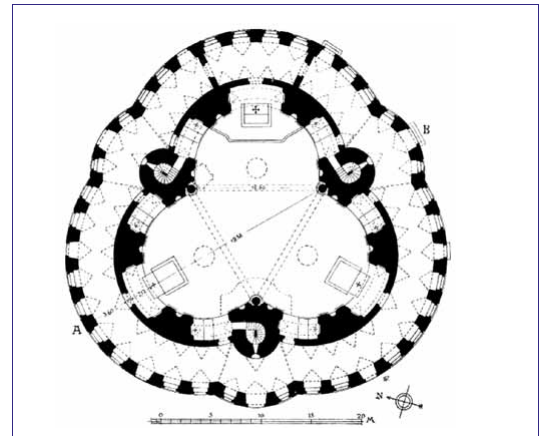
fig. 2. Waldsassen, Glasberg, pilgrim church Holy Trinity Kappl, Georg Dientzenhofer, 1685. Plan. Source : Hempel. Here after: norberg-Schulz 1966, fig.